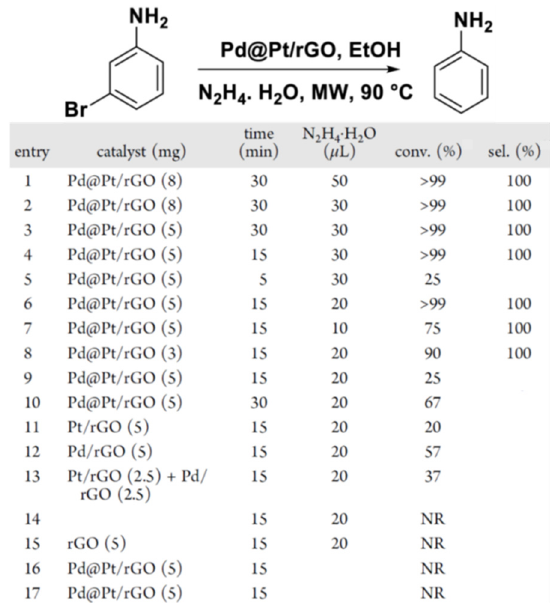
Figure 23. Schematic representation of dehalogenation of 3-bromoaniline and various catalytic results obtained are shown in the tabular form. Adapted with permission from the American Chemical Society. Copyright 2017 American Chemical Society.